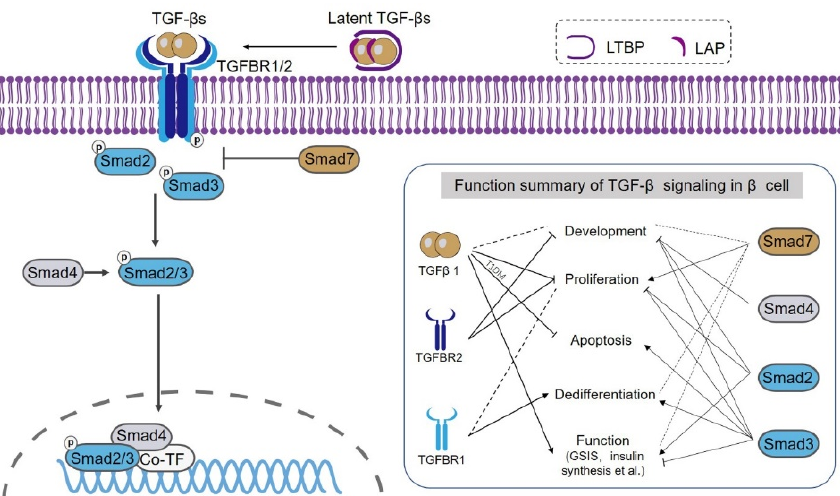
Figure 1. This schematic graph illustrates the classical TGF- β signaling and its roles in the regulation of β cell development, proliferation, apoptosis, dedifferentiation, and function. The TGF- β ligands are synthesized as latent TGF- β s. After being released, TGF- β binds to TGFBR2, which recruits and activates TGFBR1. TGFBR1 phosphorylates intracellular Smad2/3 which then binds to Smad4 and translocates into the nucleus to regulate the transcription of target genes. Smad7 negatively regulates TGF- β signaling by competing for the TGFBR1 with Smad2/3 and inducing the degradation of TGFBR1. The roles of each component of TGF- β signaling on different β cell biological processes are indicated in the insert. The solid line indicates a confirmative role while the dotted line suggests a role under debate. The line with the arrow represents positive regulation, while the line with blunted end stands for negative regulation. LAP, latency-associated peptide. LABP, latent TGF- β -binding protein.